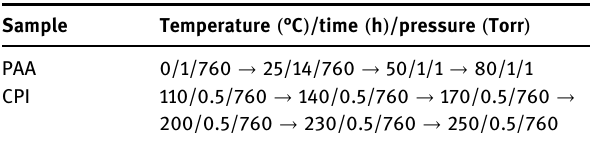
Table 1: Heat treatment conditions of the CPI fi lms obtained from the CHDA monomer Sample